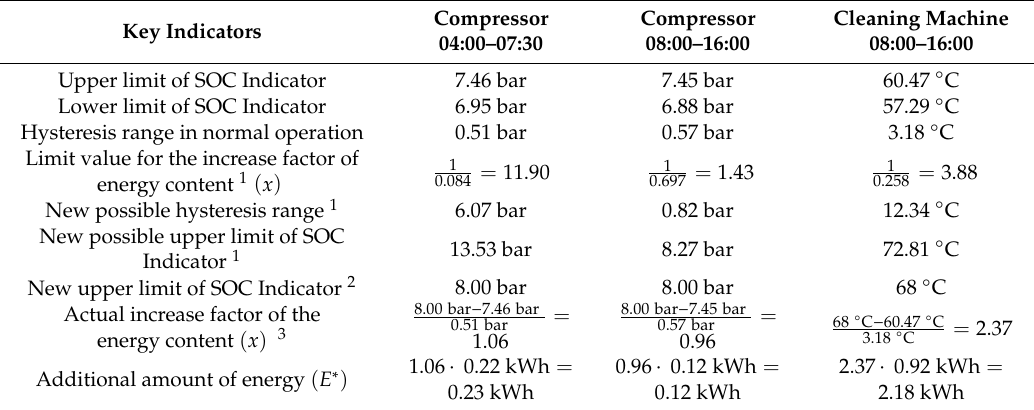
Table 4. Summary of the results of the case study (Step